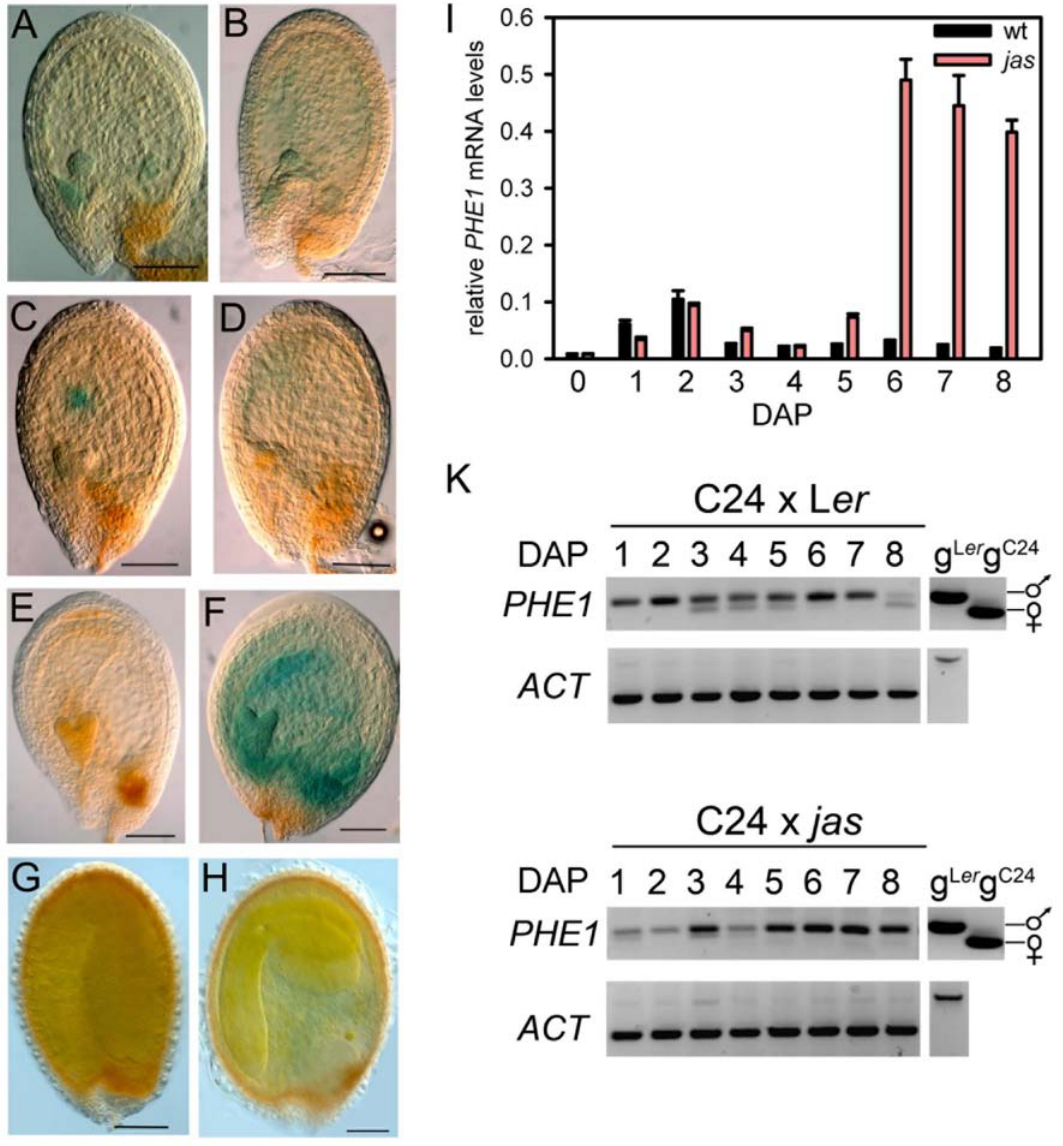
Figure 1. Overexpression of PHE1::GUS and the endogenous paternal PHE1 allele in seeds of jas plants. (A,C,E,G) PHE1::GUS expression in wild-type seeds, (B,D,F,H) PHE1::GUS expression in seeds of selfed homozygous jas plants. Seeds were analyzed at 4 (A,B), 5 (C,D), 6 (E,F) and 10 DAP (G,H). Scale bars, 100 m m. (I) Quantitative RT–PCR analysis of PHE1 expression in wild-type and jas seeds. Error bars, s.e.m. (K) PHE1 imprinting is not affected in jas seeds. Allele specific PHE1 transcript levels were determined after crosses of C24 with wild-type (L er ) or jas plants [27]. DAP; days after pollination. wt; wild type.